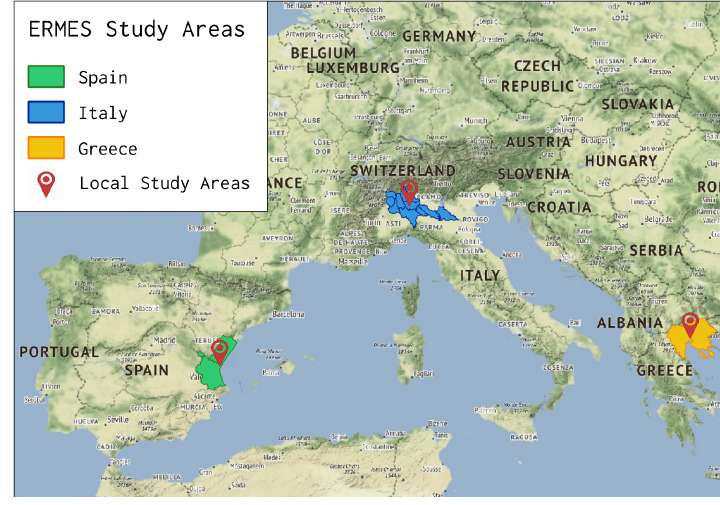
Figure 3. ERMES regional and local study